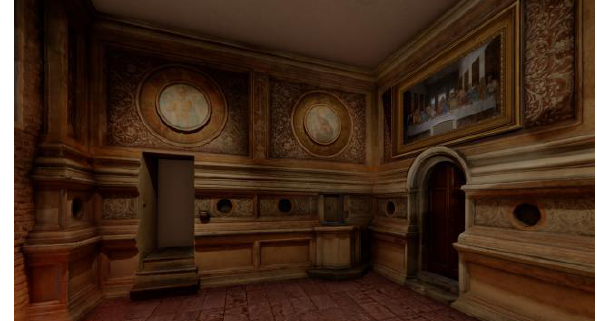
Figure 12. VR experience: The Small Sacristy.